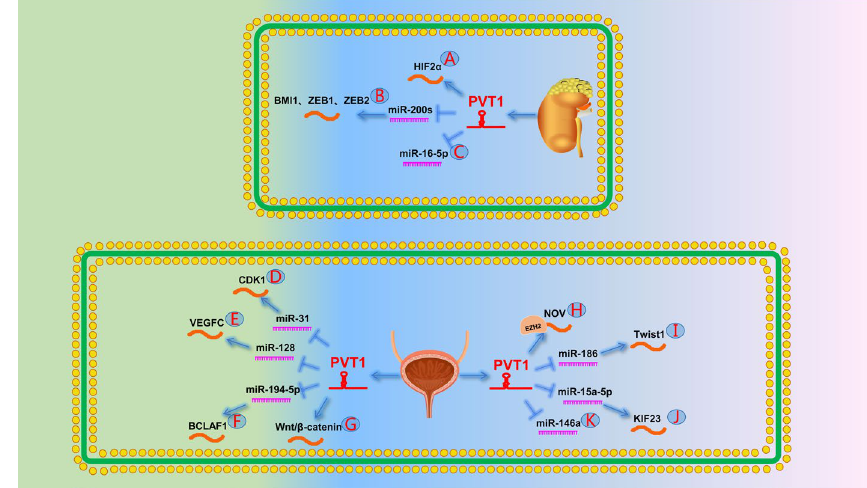
Fig. 6 The role of PVT1 in the urinary system. A PVT1 forms a positive feedback loop with HIF2α protein. B PVT1 promotes BMI1, ZEB1, and ZEB2 by targeting miR-200s. C PVT1 can directly target miR-16-5p. D PVT1 promotes the expression of CDK1 by targeting miR-31. E PVT1 promotes the expression of VEGFC by targeting miR-128. F PVT1 promotes the expression of BCLAF1 by targeting miR-194-5p. G PVT1 leads to chemoresistance in BCa by activating the Wnt/β-catenin signaling pathway. H PVT1 represses NOV expression by recruiting EZH2 to the promoter region of NOV. I PVT1 promotes Twist1 expression by targeting miR-186 and ultimately leads to EMT. J PVT1 promotes the expression of KIF23 by targeting miR-15a-5p. K PVT1 can directly target